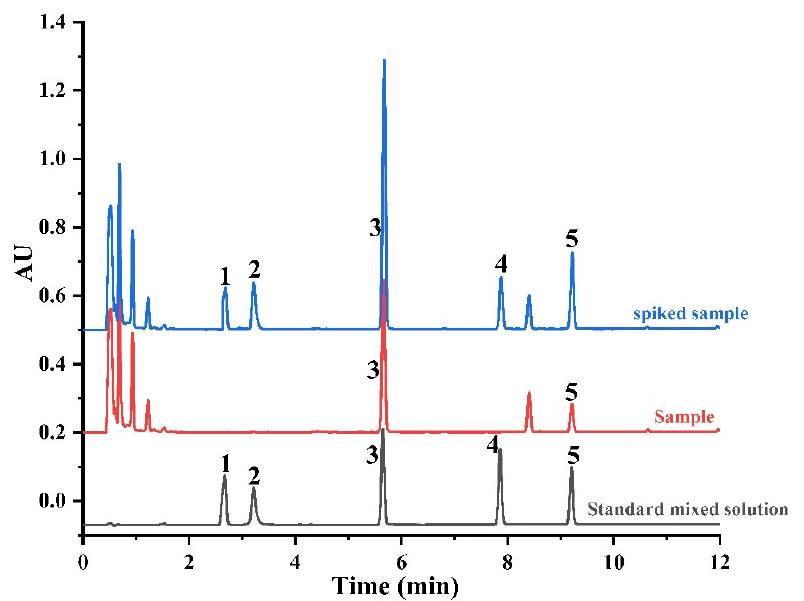
Figure 1. A chromatogram of the standard mixed solution, Polygonum multiflorum sample, and spiked Polygonum multiflorum . The identified peaks are: (1) aloe-emodin; (2) rhein; (3) emodin; (4) chrysophanol; and (5) physcion.